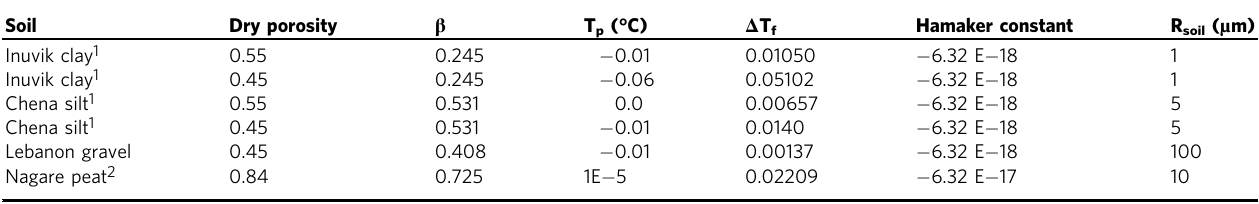
Table 1 Values of parameters for the different sediments used in SOIL8MIN model to determine unfrozen water content (S L ), a semi ‐ empirical model that includes the soil properties and the geochemical composition of soil water.